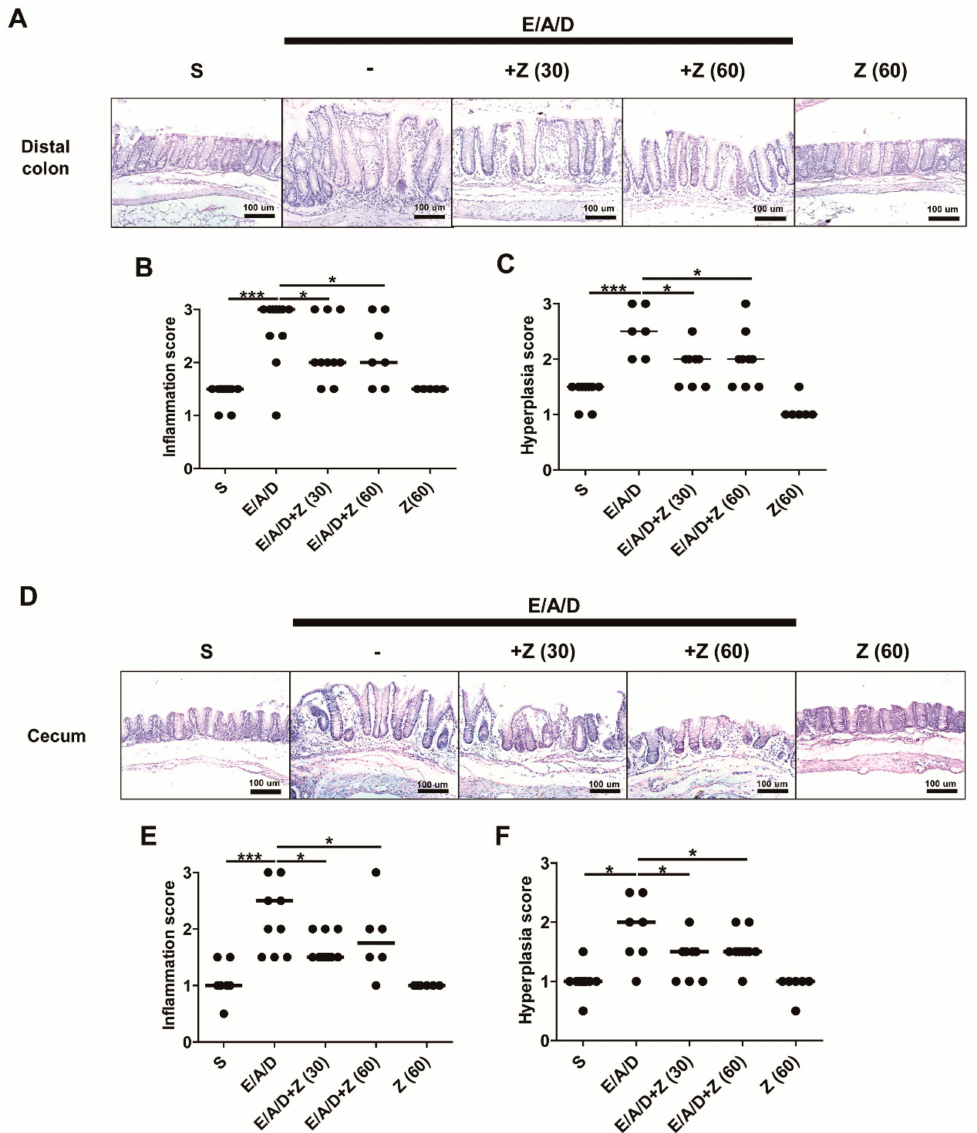
Figure 4. Zerumbone decreased large intestinal inflammation and hyperplasia in ETBF-colonized AOM / DSS mice. AOM-treated BALB / c mice were infected with ETBF and subjected to two cycles of DSS (1%) for 9 weeks. During two DSS cycles, BALB / c mice were administered with zerumbone (30 and 60 mg / kg, p.o., three times a week). ( A ) Histology (H&E) of distal colon tissues, 100 × magnification. B . Inflammation score (distal colon). ( C ) Hyperplasia score (distal colon). ( D ) Histology (H&E) of cecal tissues, 100 × magnification. ( E ) Inflammation score (cecum). ( F ) Hyperplasia score (cecum). Each dot represents one mouse. Scatter plot. Horizontal bar, median. S, sham control; E, ETBF; A, AOM; D, DSS and Z (60), Zerumbone (60 mg / kg). * p < 0.05, *** p < 0.001. ns, no statistical